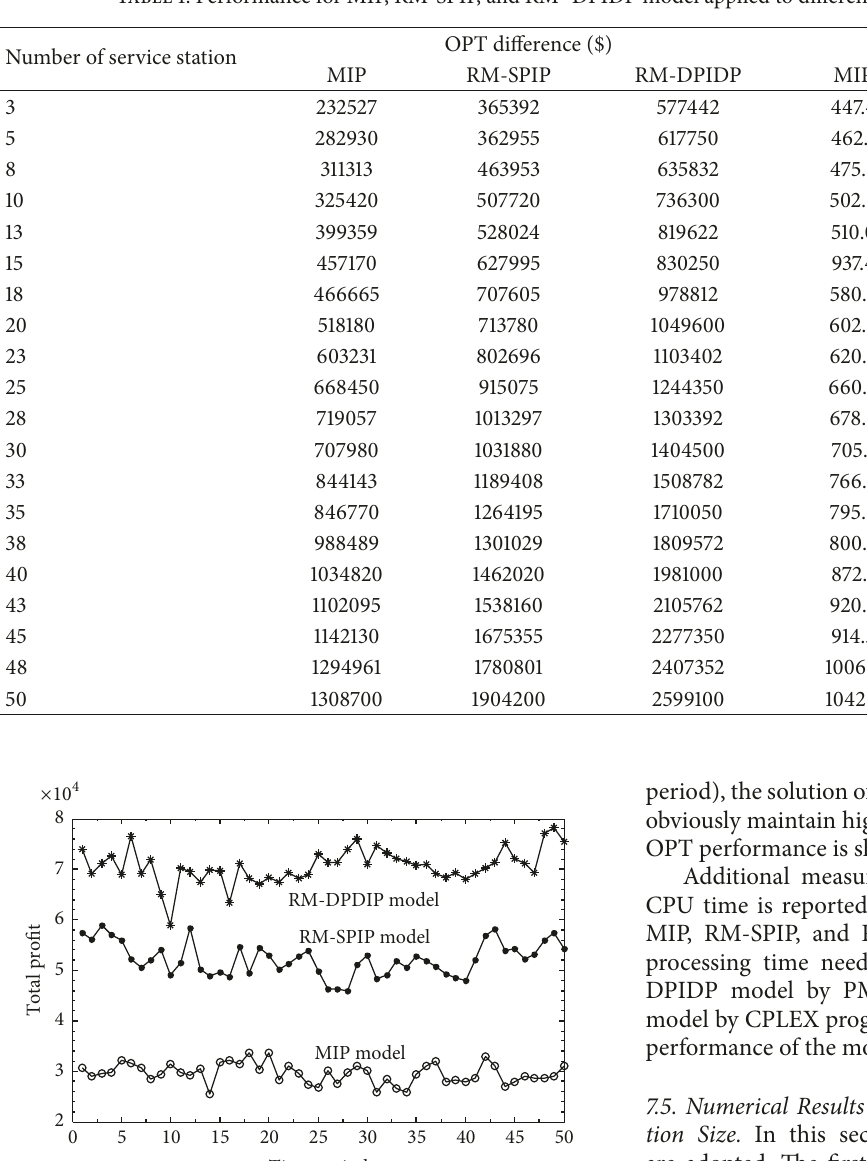
Table 1: Performance for MIP, RM-SPIP, and RM- DPIDP model applied to different working service station size.